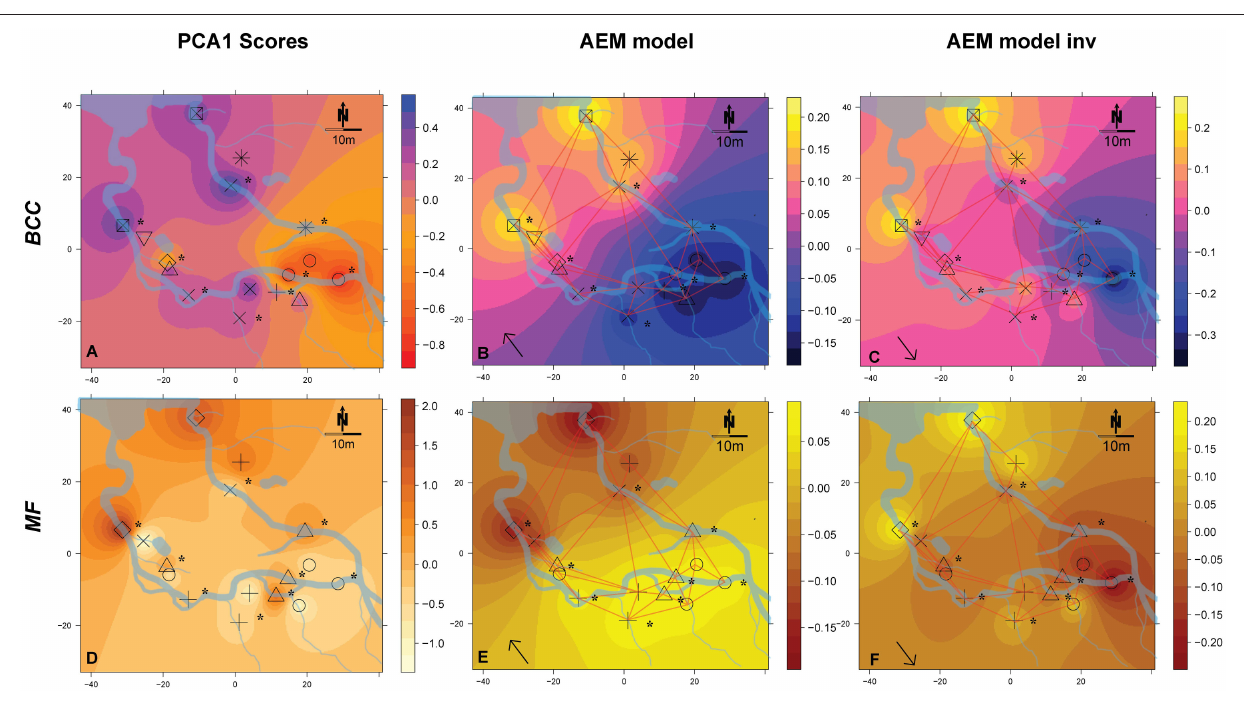
FIGURE 4 | Spatial maps of IDW inter- and extrapolations of PCA1 scores and first RDA axis values constrained by spatial explanatory variables from the significant AEM models for BCC (pink-yellow color scheme) and MF (orange color scheme) at site SC. Piezometer locations and the used connectivity grid are depicted. Symbols represent the relative affiliation of MF or BCC derived from the cluster analysis; i.e., same symbols indicate a high similarity of samples for this parameter. Asterisks depict piezometers located in-stream. Arrows depict that the interpolations are based on AEM models (single arrow). (A–C) , BCC; (D–F) , MF. Non-significant models are not